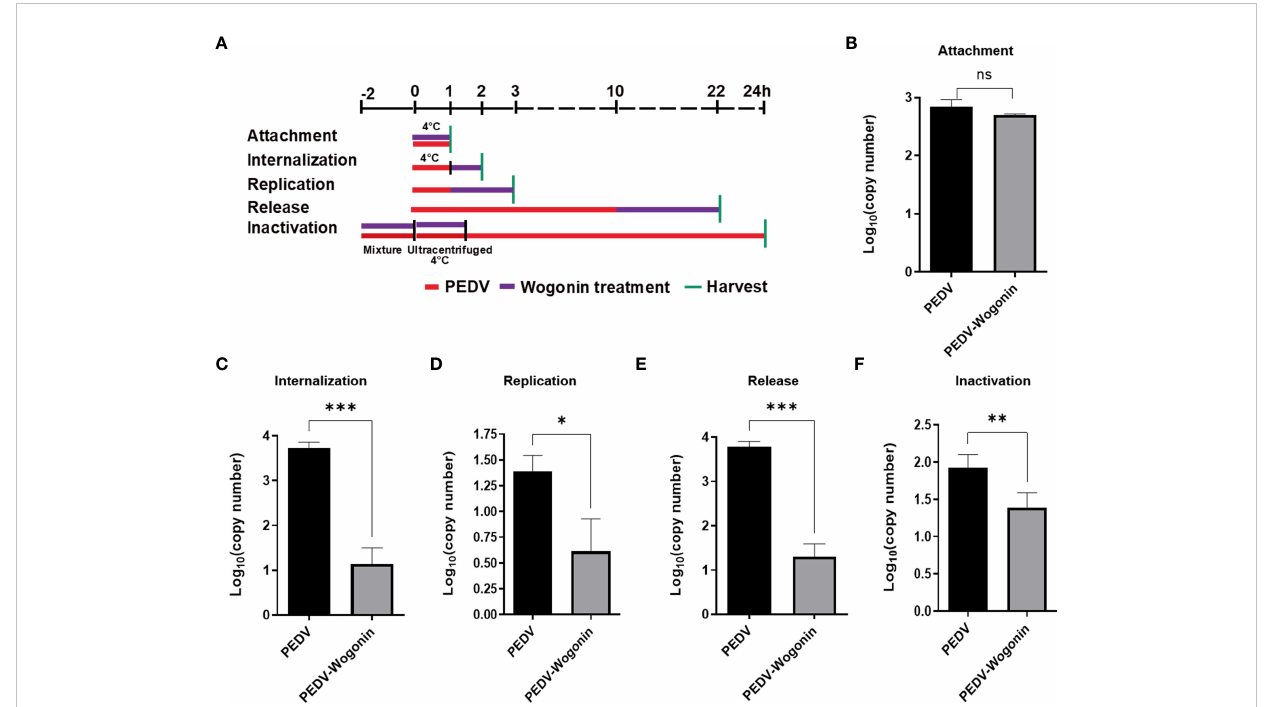
FIGURE 3 Effect of wogonin on different stages of the PEDV life cycle in Vero cells. (A) Simpli fi ed schematic representation of PEDV life cycle. (B-F) PEDV- infected cells were treated with wogonin during (B) viral attachment, (C) internalization, (D) replication, (E) release, and (F) inactivation stage. PEDV replication was determined by RT-qPCR. Values represent mean ± SD for three independent experiments. Ns indicates no signi fi cance, * P < 0.05; ** P < 0.01; *** P <